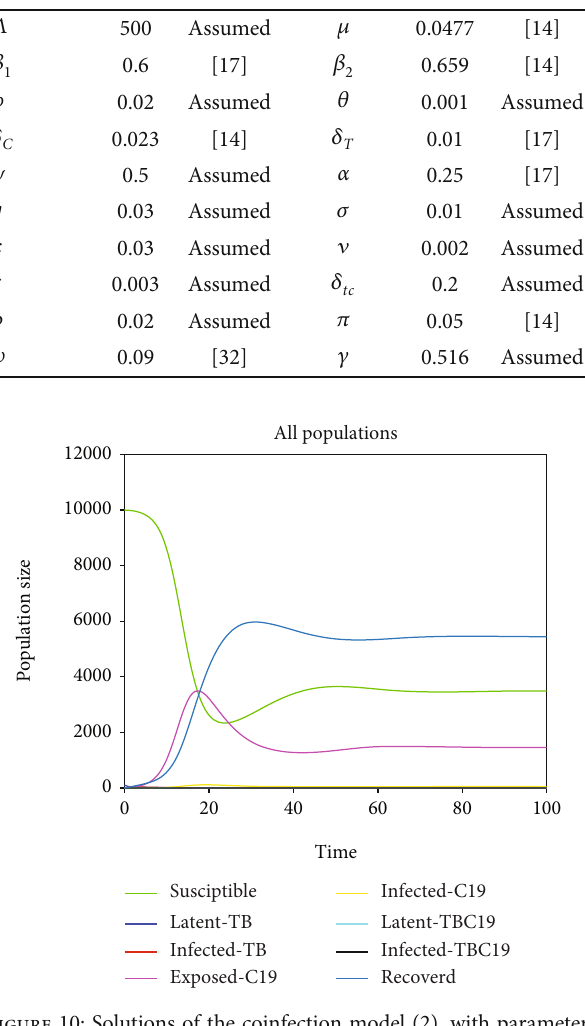
Figure 10: Solutions of the coinfection model (2), with parameter values given in Table 3.